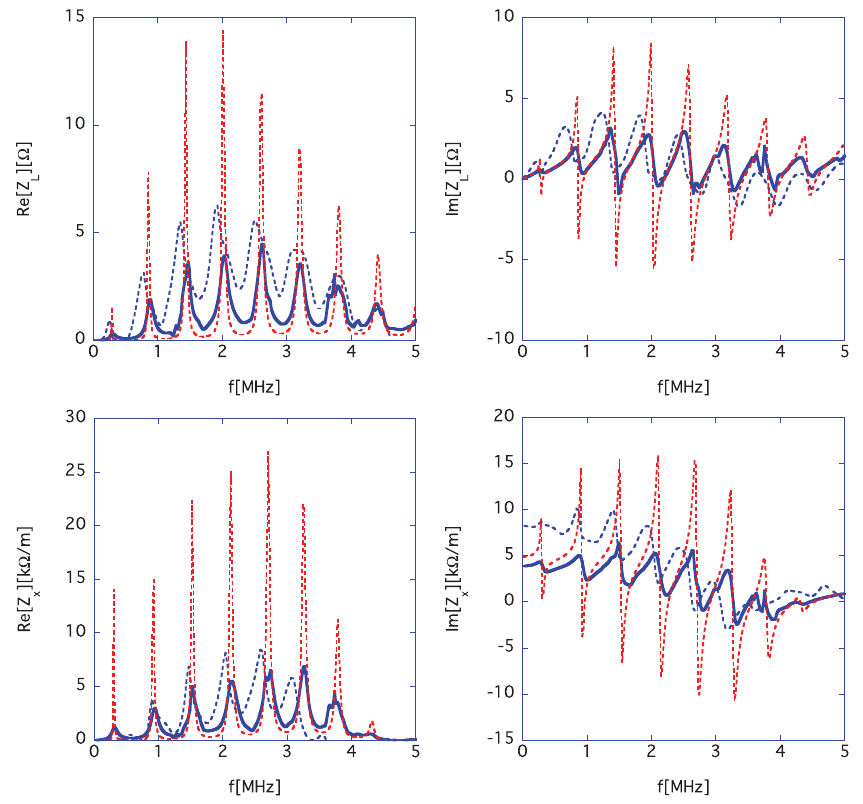
FIG. 16. The longitudinal (upper row) and horizontal (lower row) beam impedances for a relativistic beam. The blue solid and blue dashed lines show the measurements and the simulation results for 3 . 11 × 10 13 (750 kW-eq) particles per bunch when the cable terminals are terminated by the diodes with resistors, respectively. The red line shows the analytical results when the cable terminals are open. The left and the right columns show the real and imaginary parts of the beam impedances,